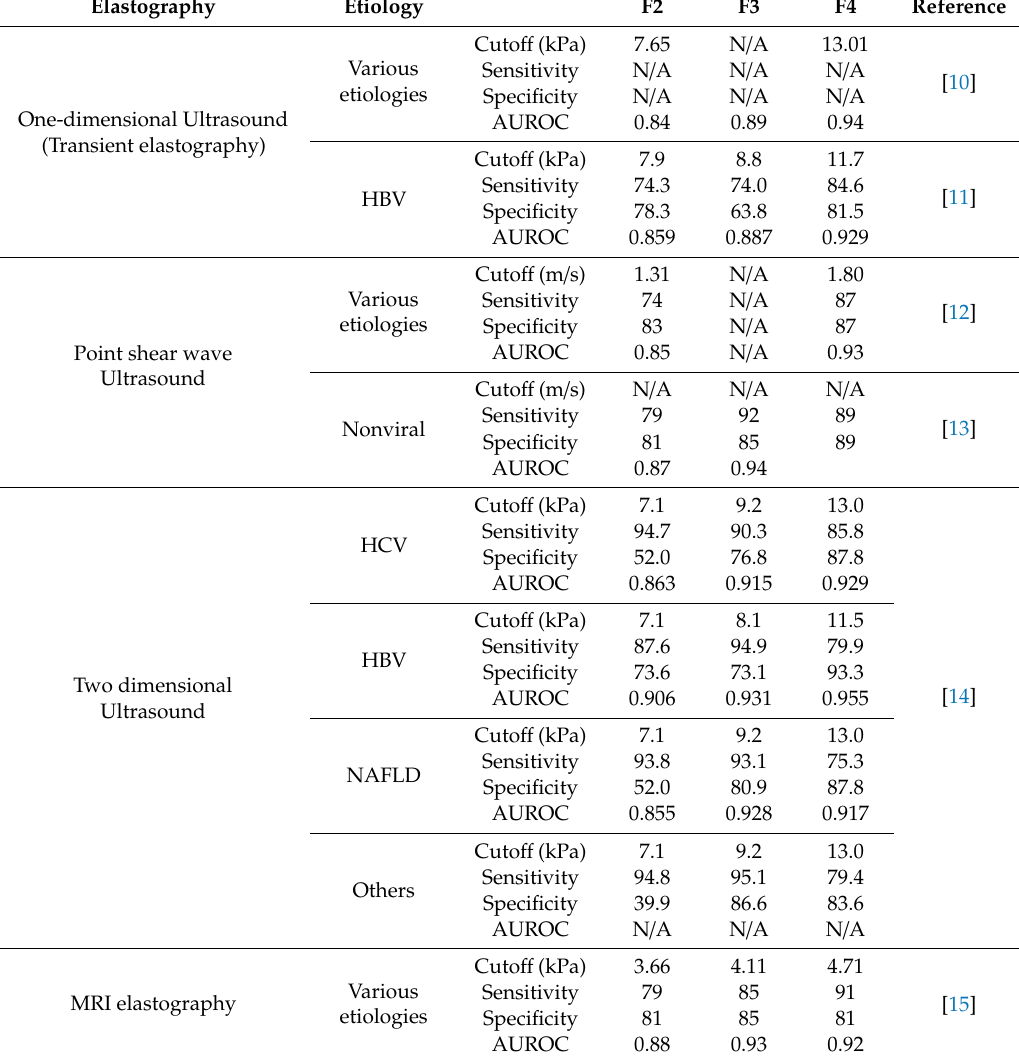
Table 1. Summary of diagnostic performances of elastography reported in meta-analyses.